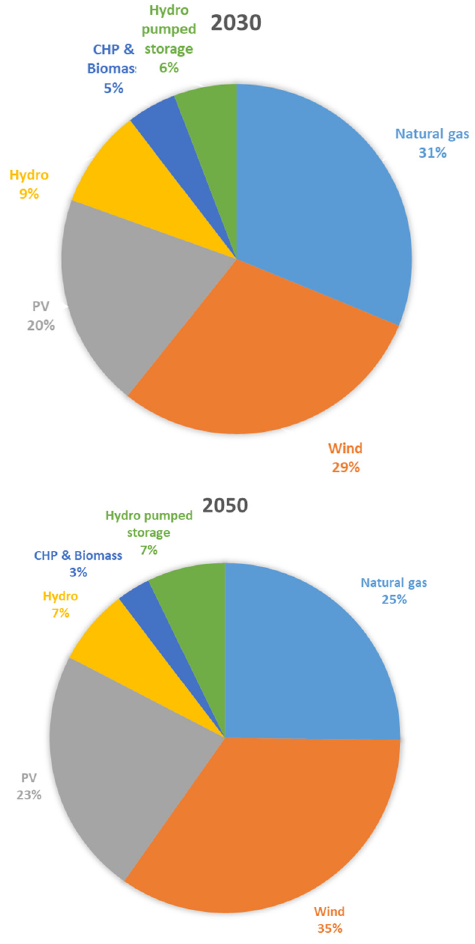
Figure 6. Energy share by technology for reference years 2030 and